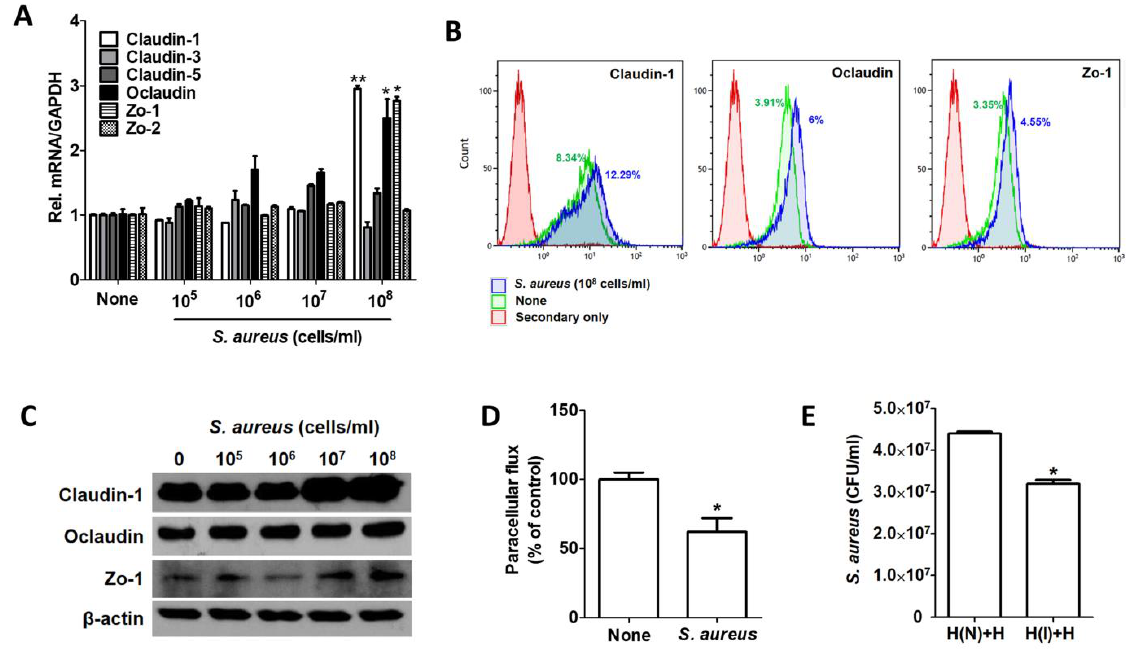
Figure 6. S. aureus -infected HaCaT cells increased tight junctions. ( A ) Tight junction–related gene expression was examined by real-time PCR after S. aureus infection for 6 h. The tight junction protein level was examined via FACS analysis ( B ) and Western blotting ( C ). ( D ) Paracellular flux was examined by measuring the amount of fluorescein that passed in a Transwell chamber. ( E ) Intracellular S. aureus CFU were examined in a Transwell chamber. The data displayed are the mean ± SD. Statistical analysis was conducted with a one-way ANOVA ( A ) or unpaired two-tailed t test ( D , E ). * p < 0.05, ** p < 0.01.